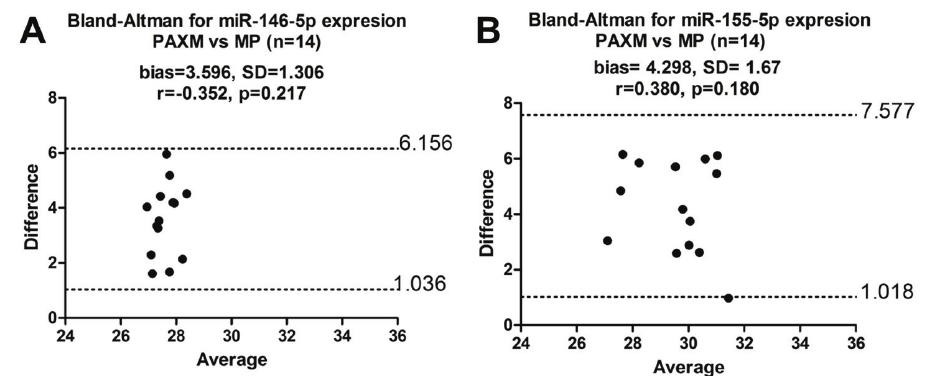
Figure 5. Bland-Altman plots for miRNA expression from whole blood and PBMCs. Total RNA was extracted (n=14) using PAXM and MP for ( A ) miR-146a-5p and ( B ) miR-155-5p expression. MicroRNA expression is within the limits of agreement but the bias is greater than one showing high disagreement between PAXM and MP. r indicates Spearman correlation. SD: Standard Deviation and bias is the mean difference. C values were used for this analysis. Dashed lines show the 95% lower and upper limits of agreement. q